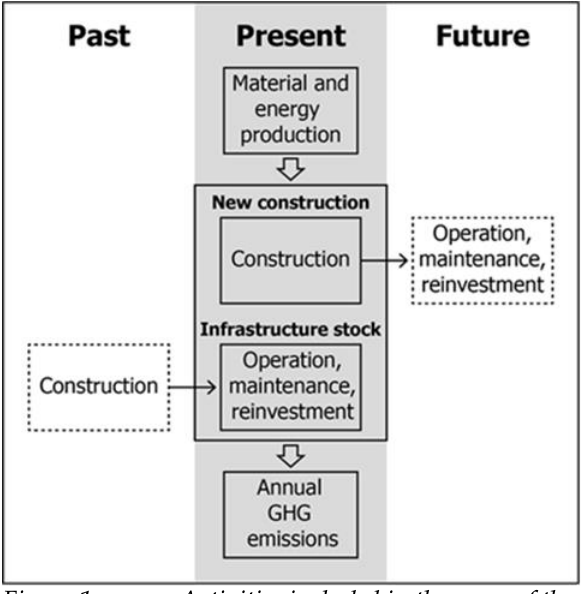
Figure 1. Activities included in the scope of the